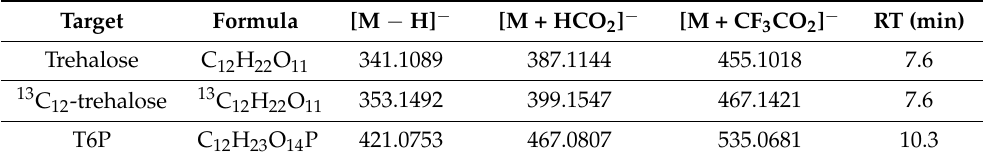
Table 1. Exact mass and retention time of the different clusters of trehalose and T6P.